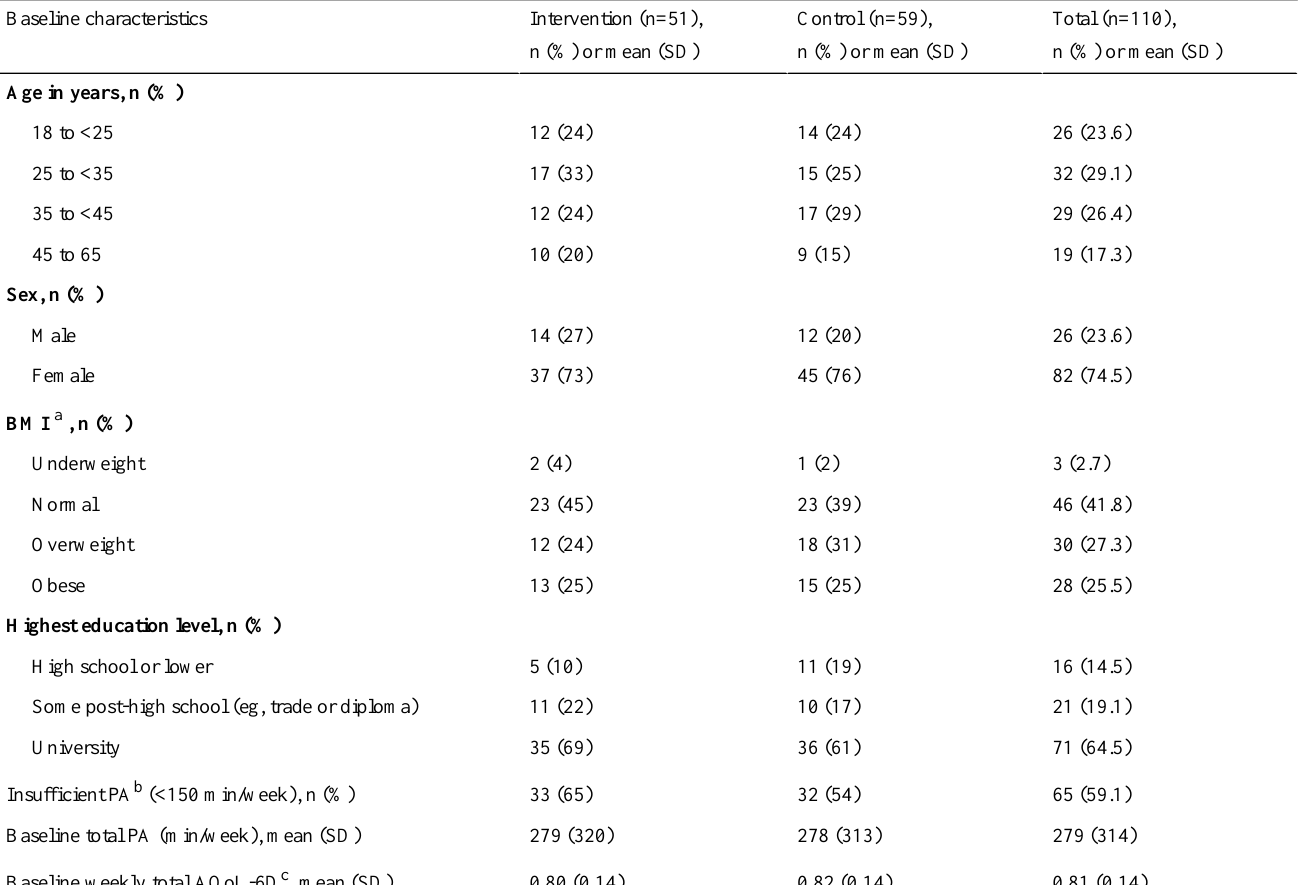
Table 1. Descriptive characteristics of the study sample at baseline